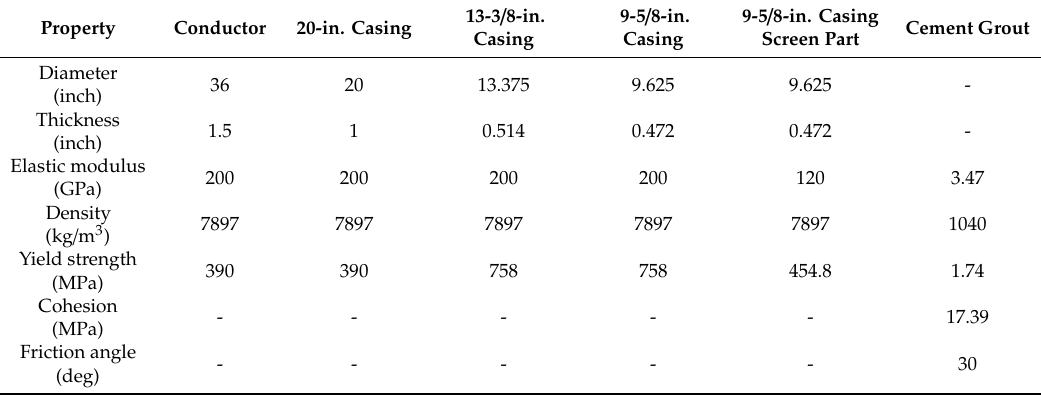
Figure 8. Schematic diagram of modeled geometry, hydrate-bearing sediment (HBS), and casing structure [24]. Table 1. Mechanical properties of the wellbore [24].